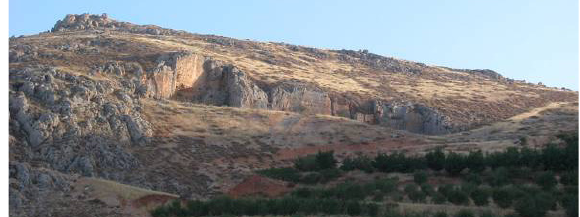
Figure 3. The quarry of Niha. © J. Yasmine; May 2005.